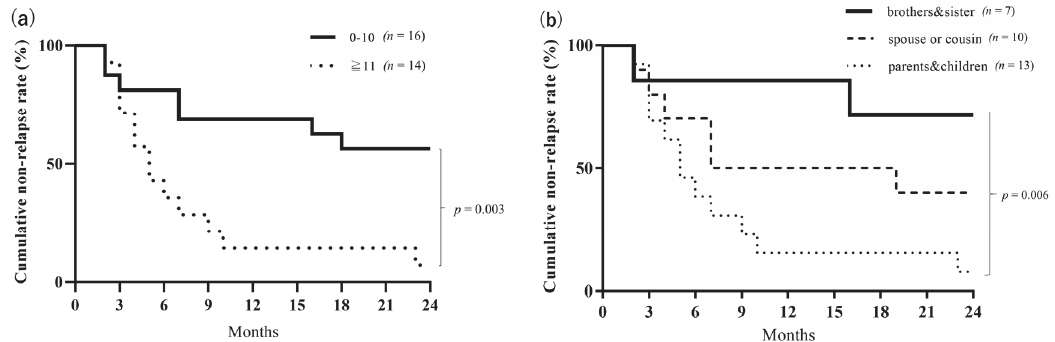
Figure 5. ( a ) Comparison of the cumulative non-relapse rate by the age di ff erence between donors and patients in the A-FMT group. In the A-FMT (fresh fecal microbiota transplantation (FMT) following triple antibiotic therapy (amoxicillin, fosfomycin, and metronidazole)) group, the ≥ 11-year di ff erence group ( n = 14) showed significantly lower cumulative non-relapse rate than the 0–10-year di ff erence group ( n = 16) for 24 months ( p = 0.003, log-rank test). ( b ) Comparison of cumulative non-relapse rate by the relationship between donors and patients in the A-FMT group. In the A-FMT (fresh fecal microbiota transplantation (FMT) following triple antibiotic therapy (amoxicillin, fosfomycin, and metronidazole)) group, sibling FMT ( n = 7) had a significantly higher cumulative remission rate than parent-child FMT ( n = 13) for 24 months ( p = 0.007, log-rank test).